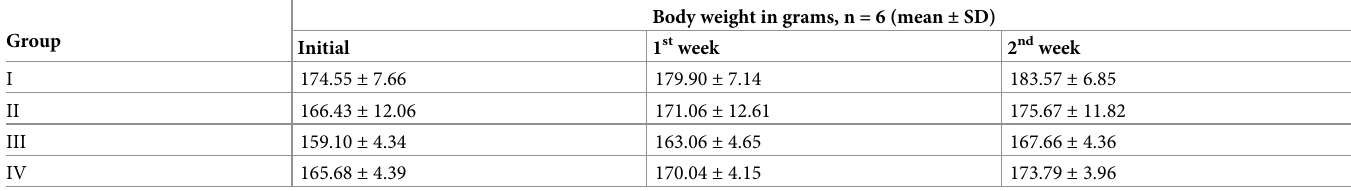
Table 6. Effect of PDAS (DS = 2.842) in distilled water on body weight increment of treated and control rats during acute toxicity study. Group